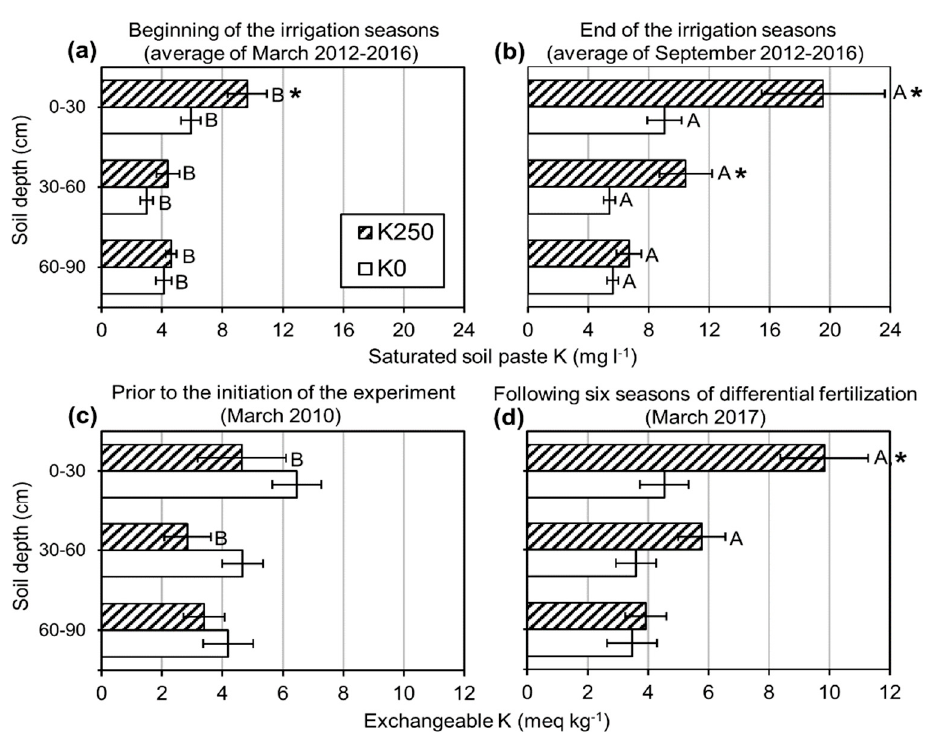
Figure 1. Influence of K fertilization on soil saturated paste K content and soil exchangeable K. Experiment plots were fertilized from 2011 season either with an annual amount of 250 kg K ha − 1 (K250) or without K (K0). ( a , b ) Saturated soil paste K mean contents calculated for March ( a ) or September ( b ) sampling dates in 2012–2016 seasons. ( c , d ) Soil exchangeable K content prior to the initiation of the experiment ( c ; March 2010) and following six seasons of di ff erential fertilization ( d ; March 2017). Numbers are mean values of seven replicates (plots) ± standard error of the mean (bars). Di ff erent letters indicate significant statistical di ff erence between dates (March to September ( a , b ); 2010 to 2017 ( c , d )) in the same plots and asterisks between K fertilization levels (K250 to K0) at the same date according to Student’s t -test ( p ≤ 0.05).